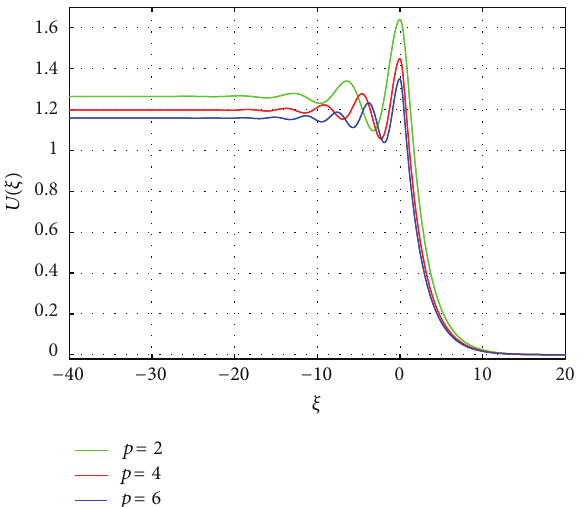
Figure 22: Plot of the approximate damped oscillatory solution (33) for different values of 𝑎 , 𝑏 when 𝑐 = 0.2 , 𝑝 = 2 , 𝛽 = 1 , and 𝑟 = −0.5